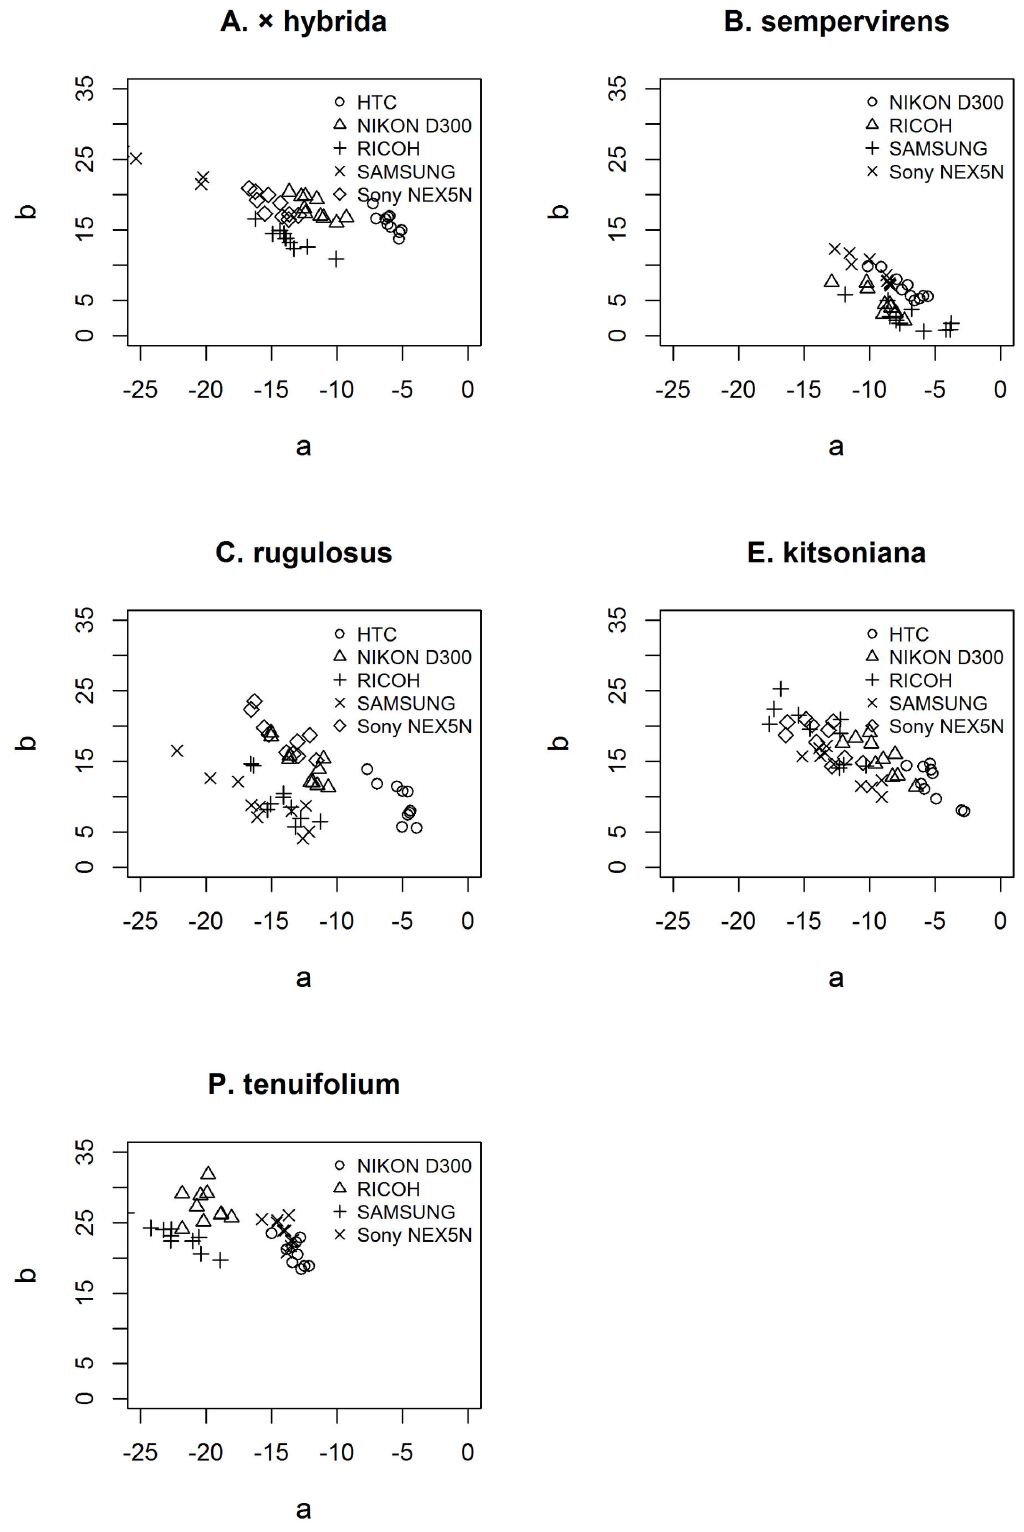
Figure 3. Variation in leaf colour measured by different cameras. Leaf colour is shown in a* - b* space for five species calculated from images taken with five different digital cameras. doi: 10.1371/journal.pone.0072296.g003 PLOS ONE |